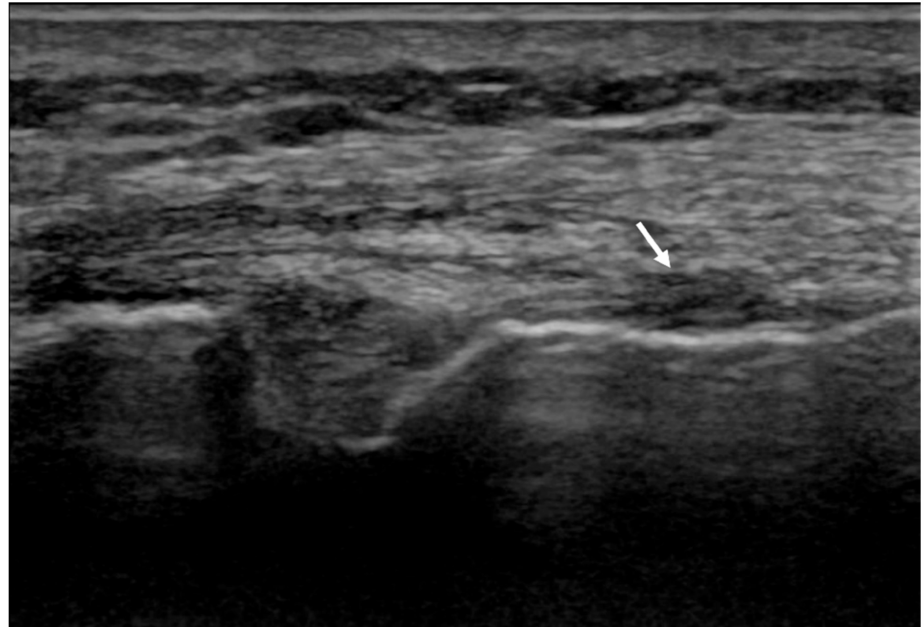
Figure 2. The 4-month follow-up ultrasound (US) examination of the MCL at the site of the previous injury